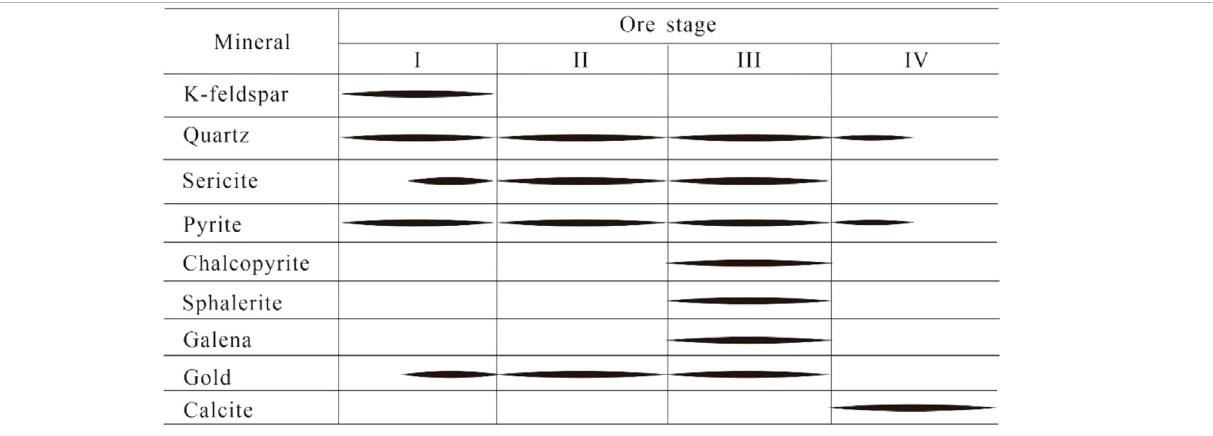
TABLE 1 | Mineralization stage and mineral paragenetic